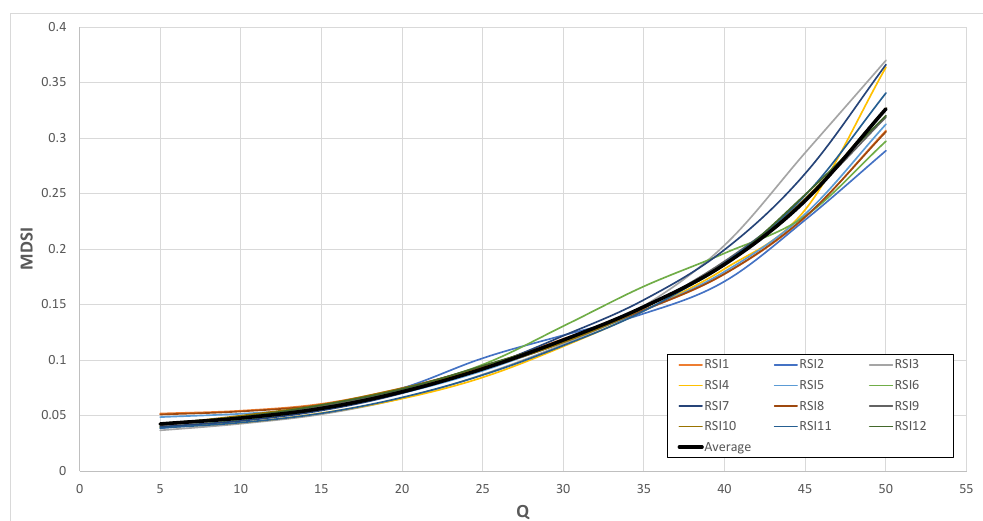
Figure 6. Curves of the MDSI dependence on the Q parameter for individual basic images (RSI #1–#12) and the obtained average